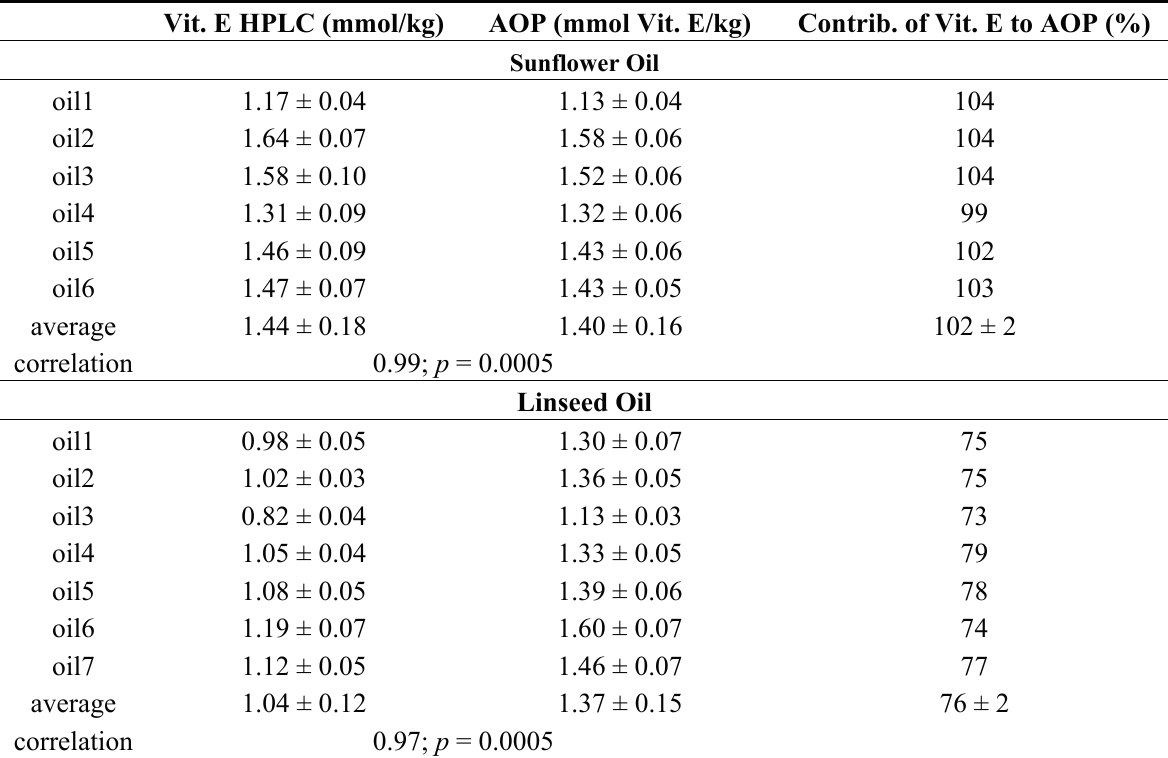
Table 2. Vitamin E contents and contributions of vitamin E to antioxidant potential (AOP) in sunflower and linseed